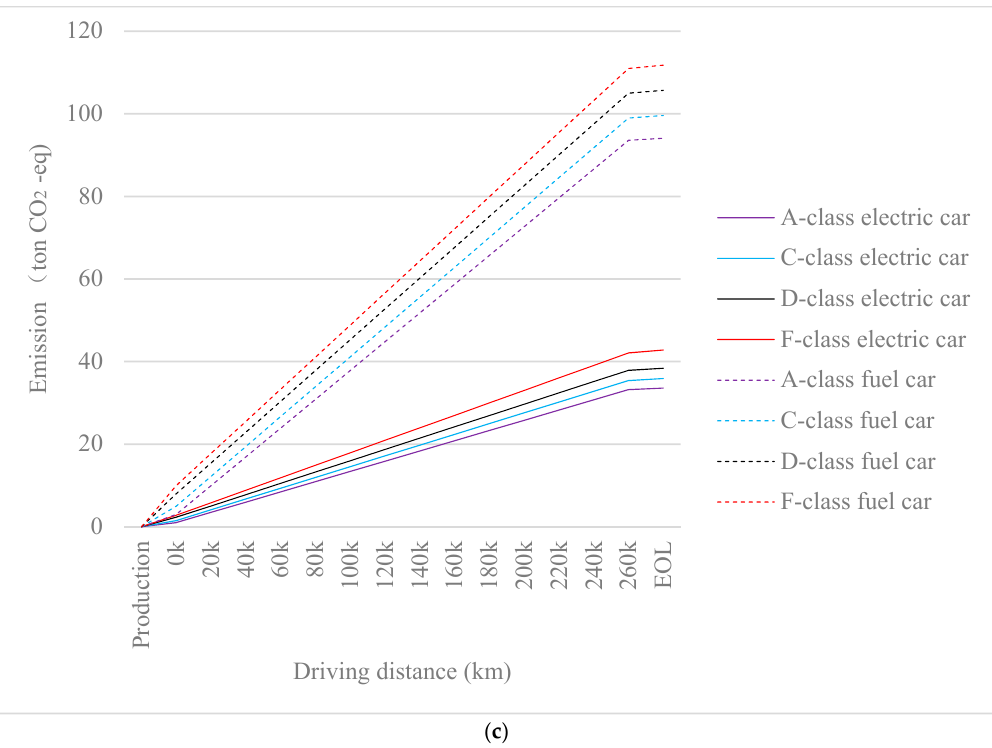
Figure 5. ( a ) Comparison of carbon emissions of two types of vehicles under the grid mix composition in 2020; ( b ) Comparison of carbon emissions of two types of vehicles under the grid mix composition in 2030; ( c ) Comparison of carbon emissions of two types of vehicles under the grid mix composition in 2050.